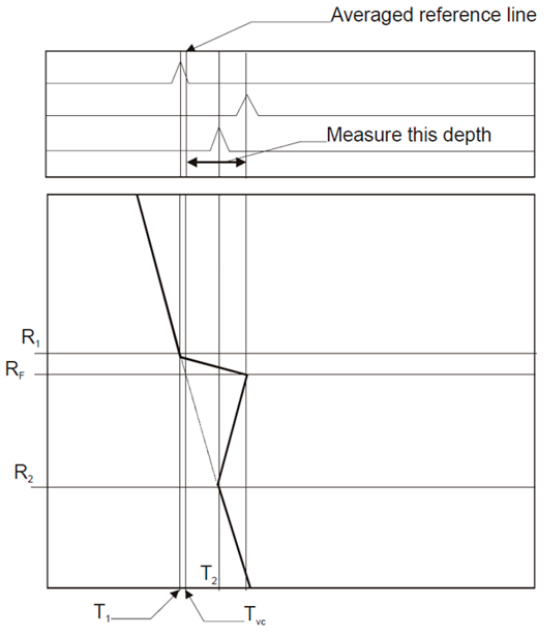
Figure 3. The manual depth measurement process using A-Scans.